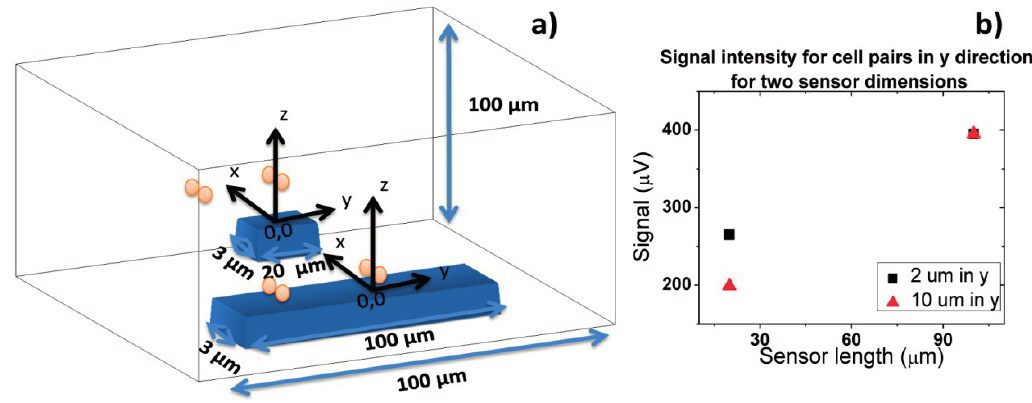
Figure 19. ( a ) Schematics of cell flow over two types of SVs; ( b ) Signal amplitude for two types of SVs obtained from simulations for two pairs of cells oriented along y axis and separated by 2 and 10